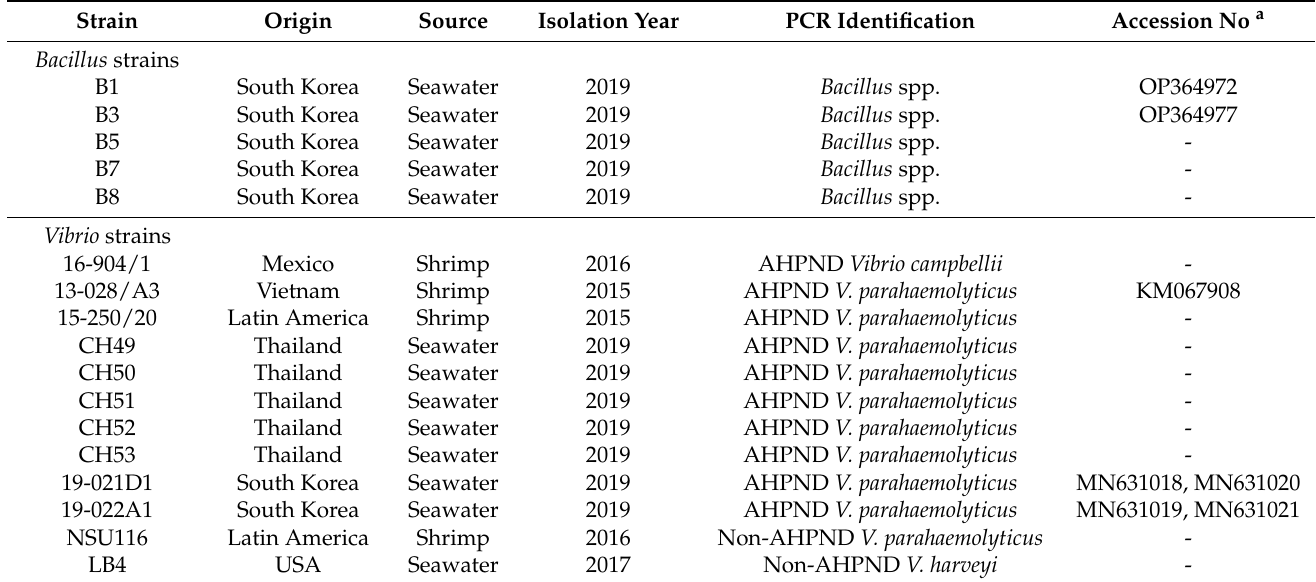
Table 2. Bacillus and Vibrio strains and their identification using